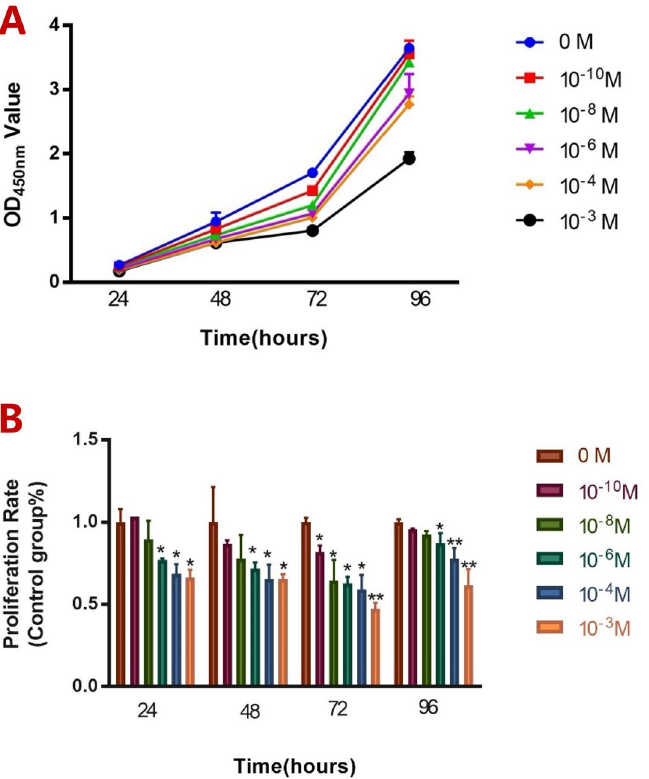
Figure 1. Effect of melatonin on ALCs’ cell number. Cells were treated with various concentrations of MT (0, 10 –10 , 10 –8 , 10 –6 , 10 –4 and 10 −3 M) for 24, 48, 72 and 96 h respectively. Subsequently, the viability of the cells was measured via a CCK8 assay. Each value was presented as mean ± SD for triplicate cultures. ( A ) Growth curve of ALCs in different concentrations of MT at different periods. ( B ) The proliferation rate of ALCs in different concentrations of MT at different periods. (*p < 0.05, **P < 0.001, compared to